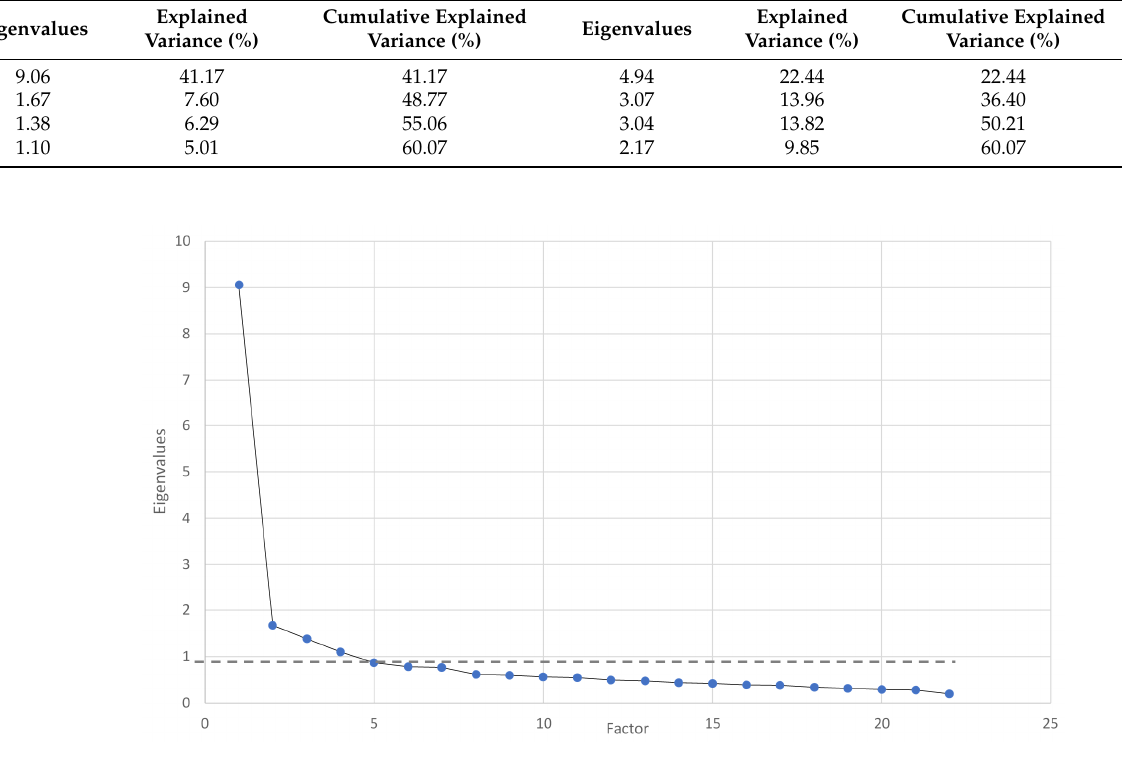
Figure 1. Scree Plot of EFA. Table 3 shows the factor loading of the items for each factor. Table 3. Loading of items in BWAQ after Oblimin